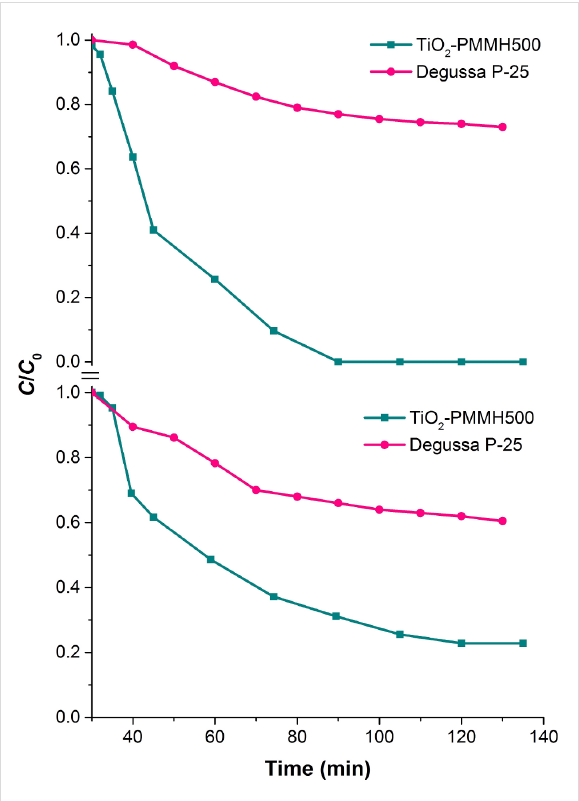
Figure 12: Comparison of photocatalytic activity of TiO 2 -pillared MM with the commercial photocatalyst Degussa P25 upon degradation of methyl orange (MO) and rhodamine B (RhB) dyes in aqueous solution.